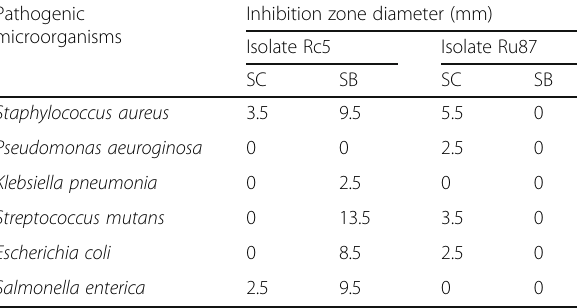
Table 1 Screening assay of antimicrobial activity of potent selected rare actinobacteria isolates against food- and blood- borne pathogens Pathogenic